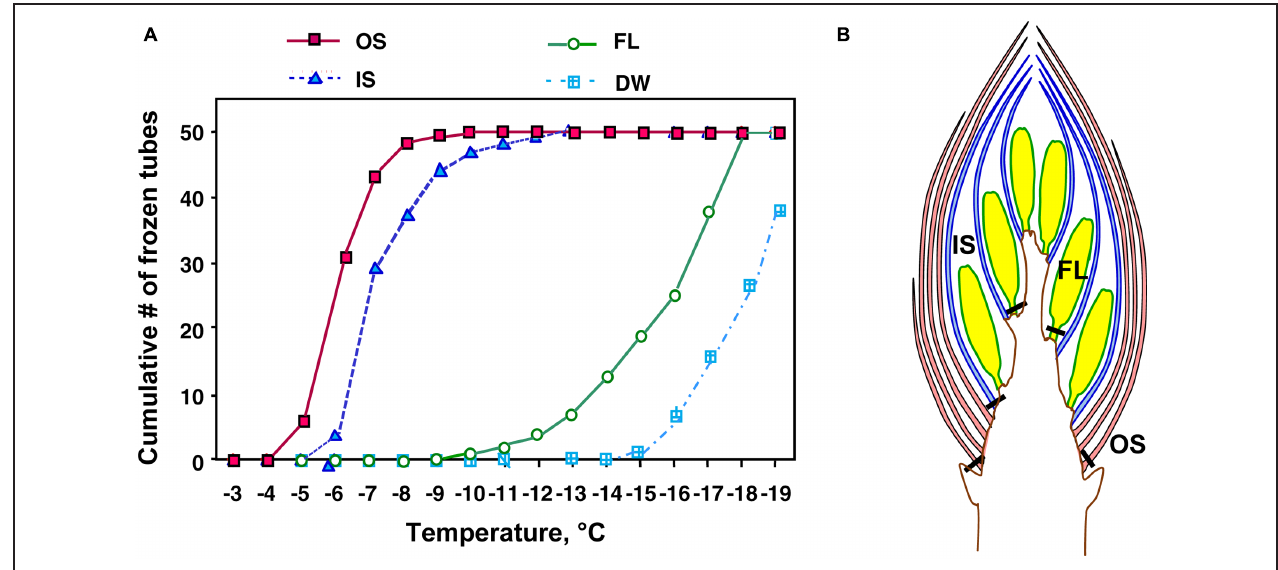
FIGURE 4 | A typical result of test tube-based INA assay (A) of outer scales (OS), inner scales (IS) and florets (FL) excised at the positions shown in (B) from wintering R. japonicum flower buds collected in early